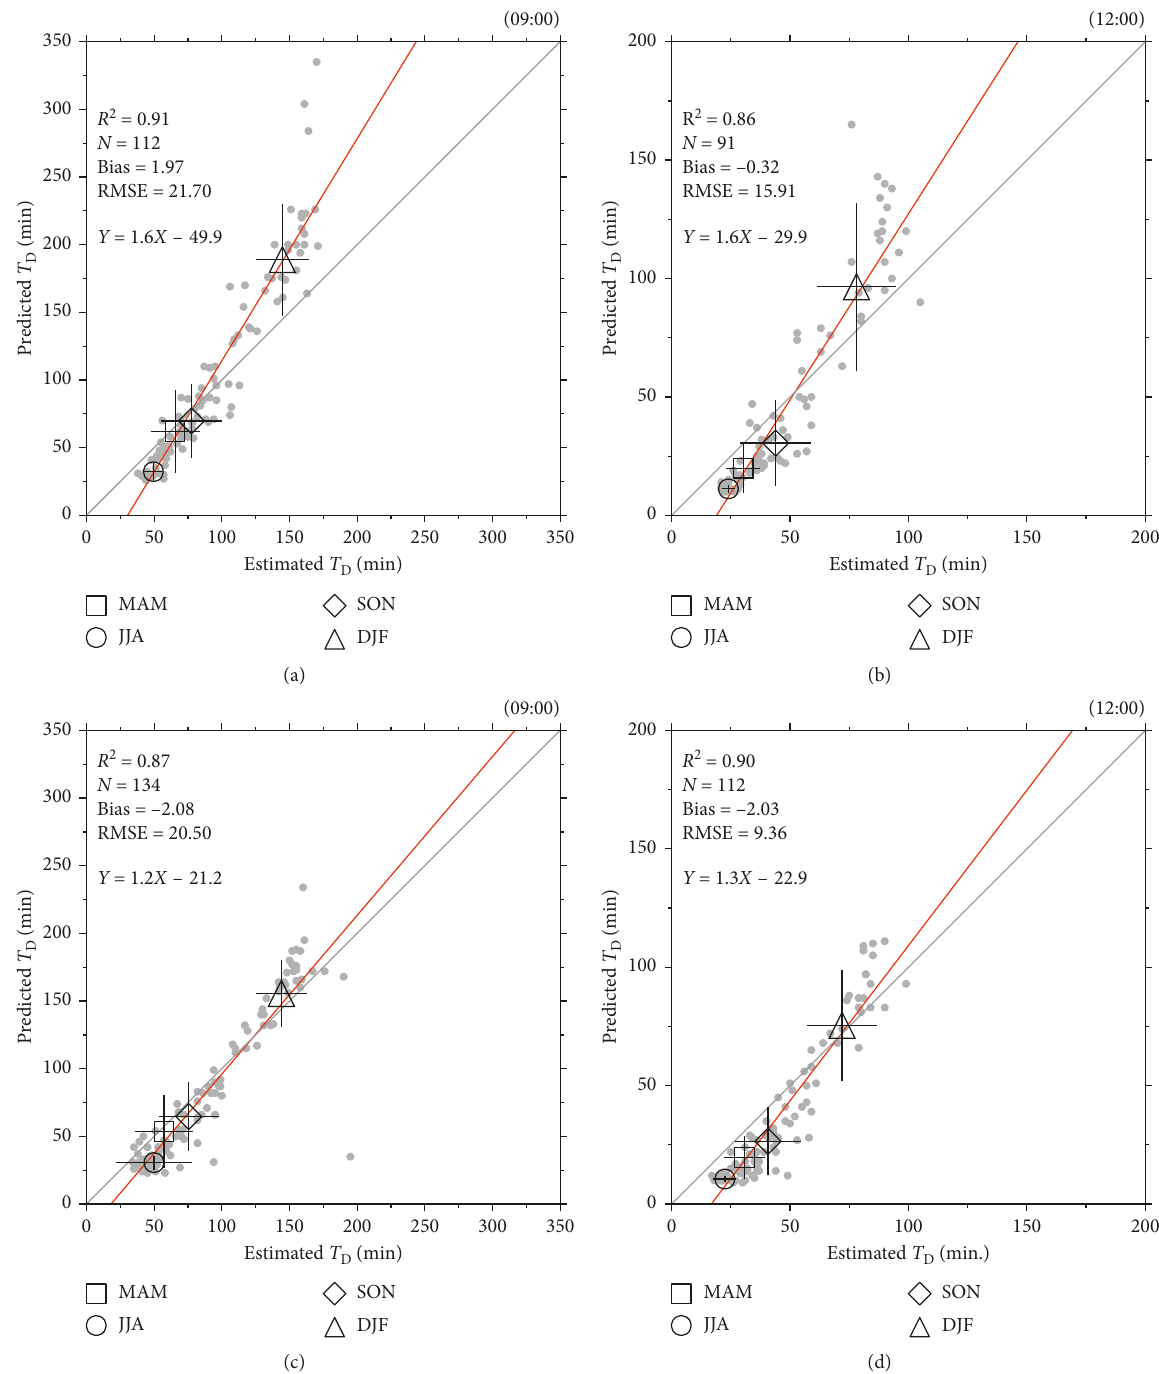
Figure 7: Scatter plot of threshold exposure time for vitamin D between the observation (Estimated T (Predicted T D ) based on cloud-free conditions in (a) Seoul at 9:00 (Korea Standard Time; KST) and (b) at 12:00 (KST) and in (c) Pohang at 9: 00 (KST) and (d) at 12:00